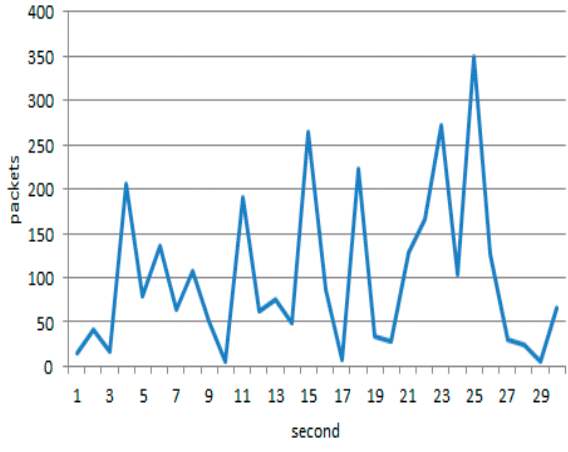
Figure 18. Background flows from normal user.